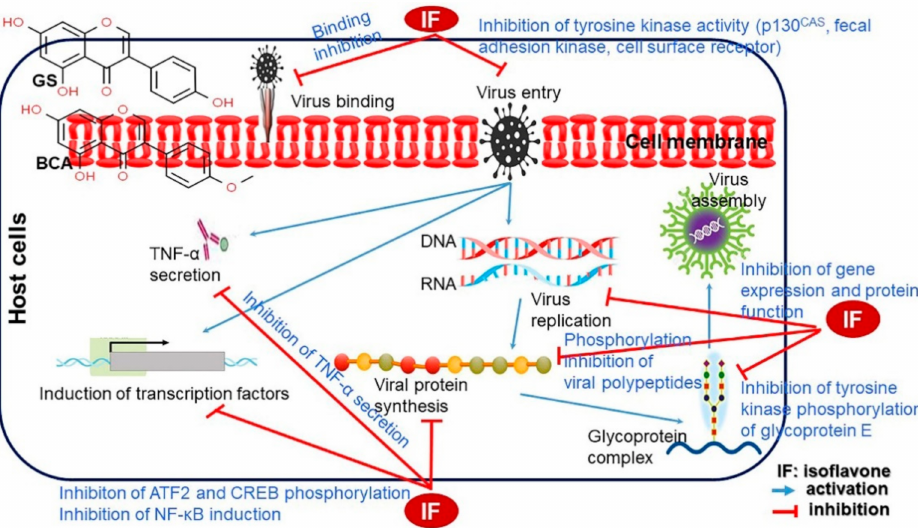
Figure 12. Antiviral effect of isoflavone (IF). IF inhibits virus binding and entry via tyrosine kinase inactivation into the host cells. IF also inhibits of secretion of tumor necrosis factor-alpha (TNF- α ), phosphorylation of activating transcription factor 2 (ATF2), cyclic AMP-responsive element- binding protein (CREB), tyrosine, glycoprotein E, and viral polypeptides, as well as prevents the induction of nuclear factor kappa B (NF- κ B) and activation of genes and proteins associated with virus assembly [300]. Figure adapted from Andres et al.